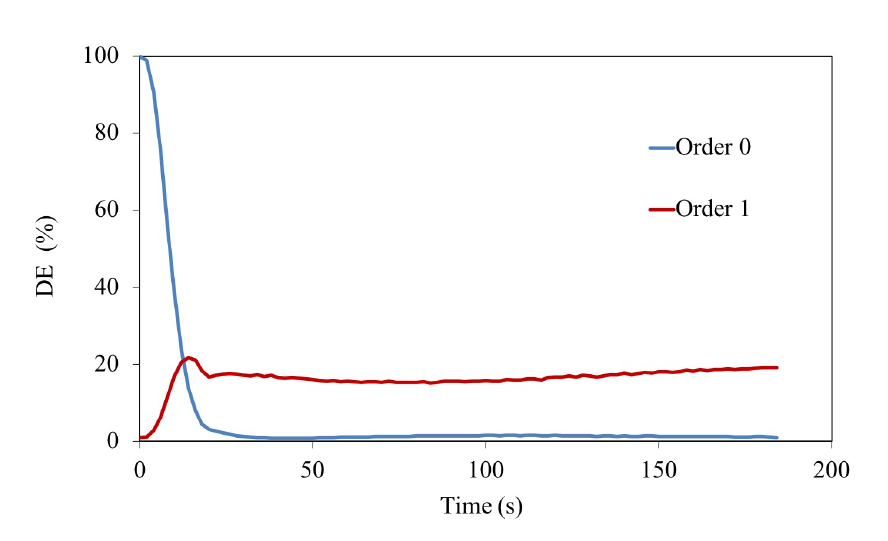
Figure 5. DE of the Fork grating recorded in 90 µ m AA/PVA